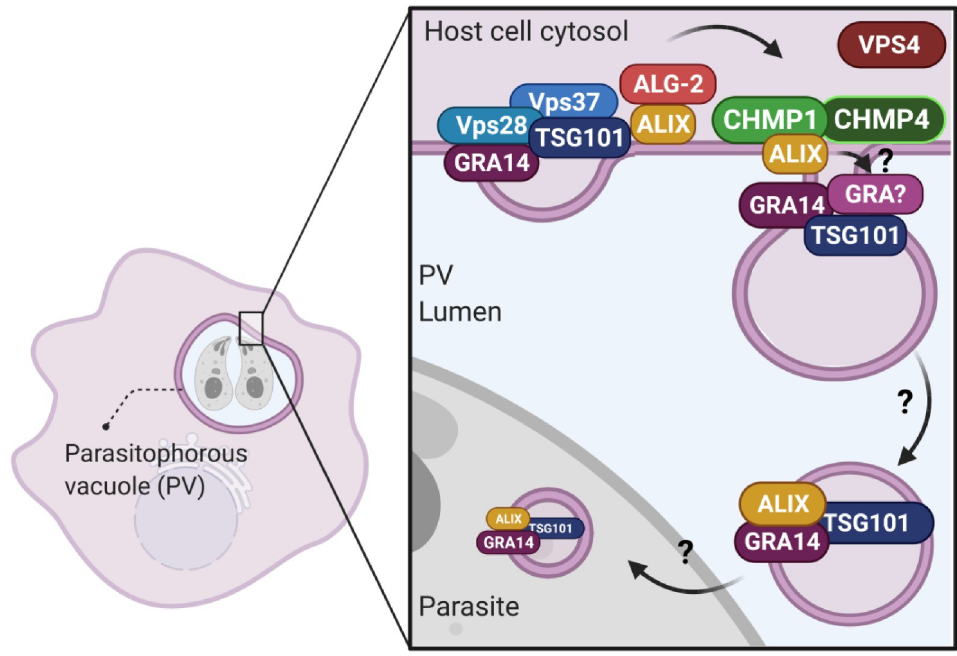
Fig 9. Model of TgGRA14-ESCRT interactions for the uptake of host cytosolic proteins. Our data supports a model for the interaction of TgGRA14 with the host ESCRT machinery at the PVM for the uptake of host cytosolic proteins. We hypothesize that through this interaction, vesicles packaging host cytosolic proteins are formed at the PVM and are further endocytosed by the parasites by an unknown mechanism. ESCRT components like TSG101 and ALIX could potentially be packaged within these vesicles resembling what occurs in ESCRT-dependent exosome formation. Furthermore, other transmembrane or soluble dense granule proteins are likely contributing to this pathway.